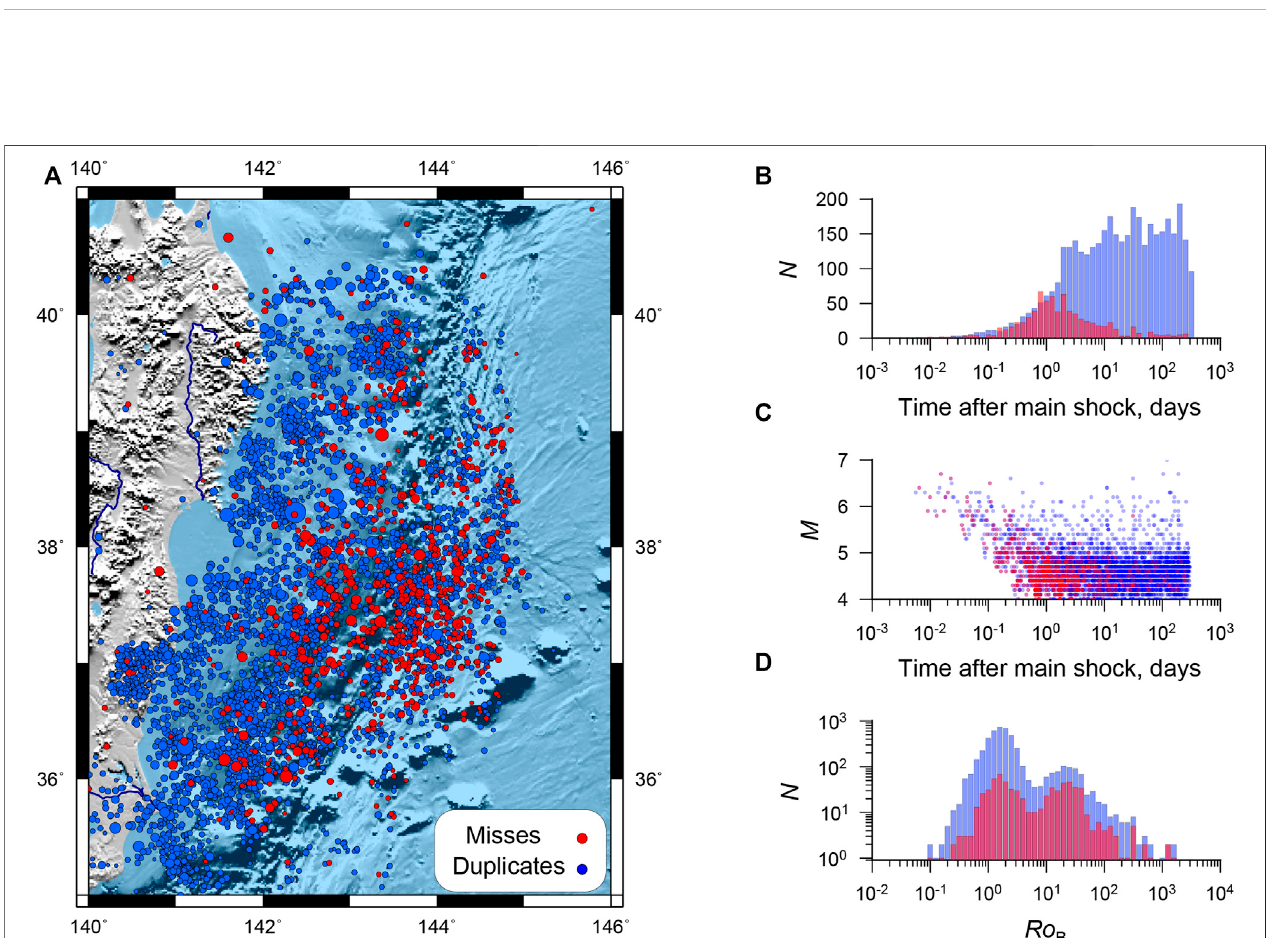
Frontiers in Earth Science |